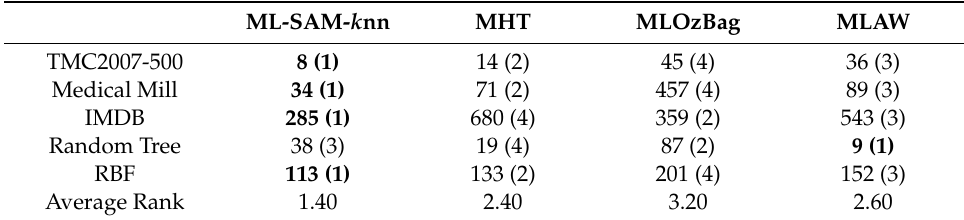
Table 8. Running time of different algorithms (CPU second).